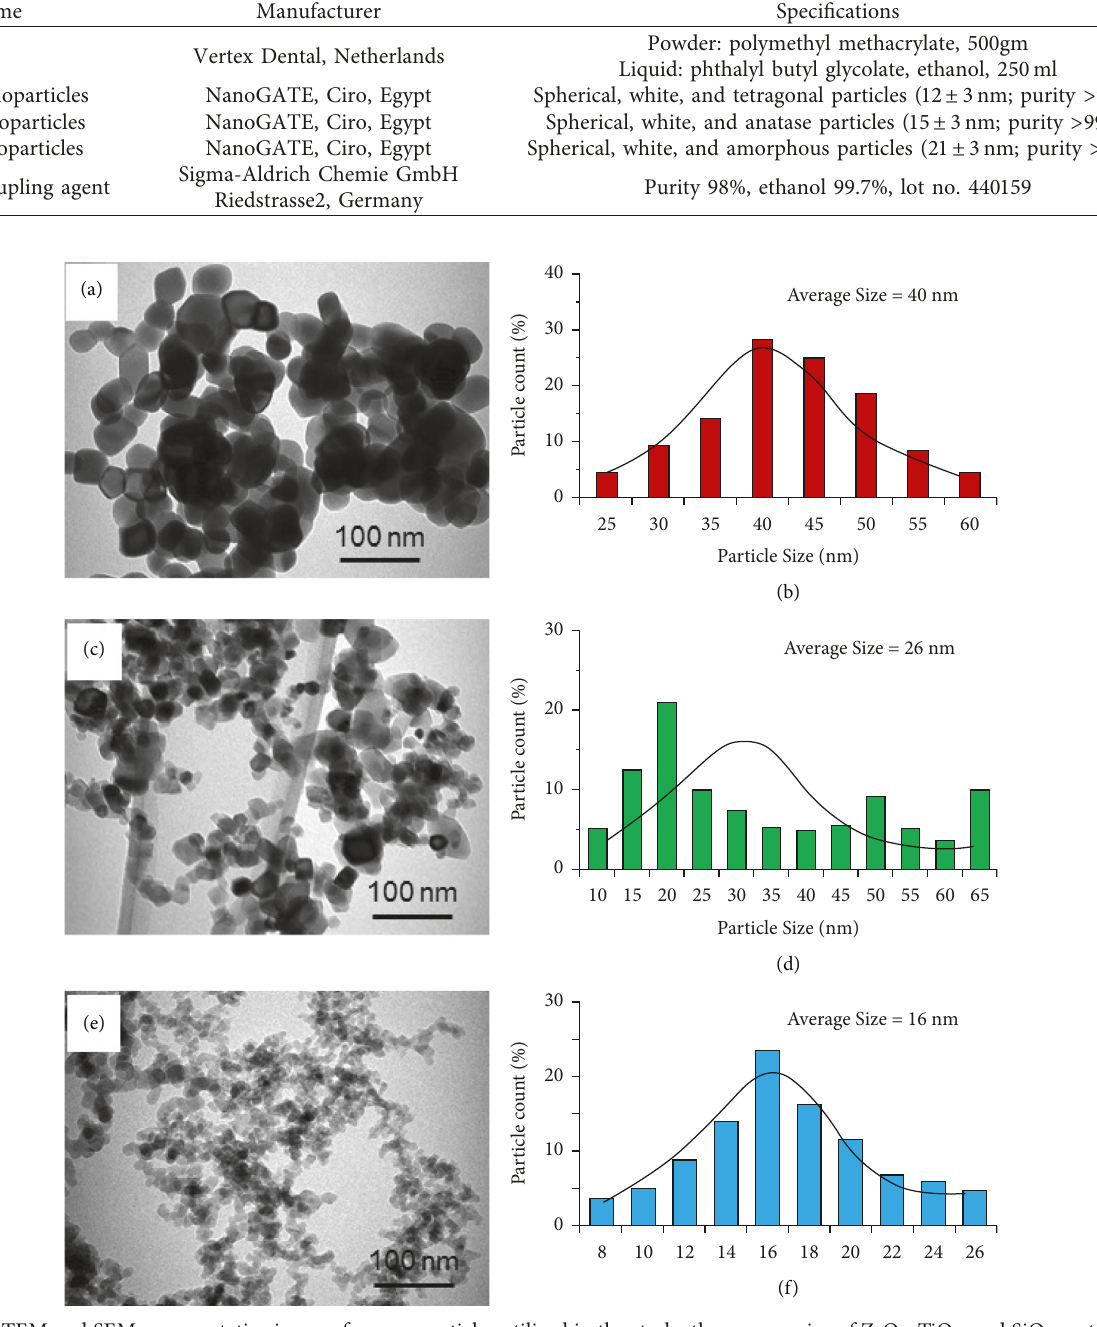
2 , TiO 2 , and SiO 2 particles is